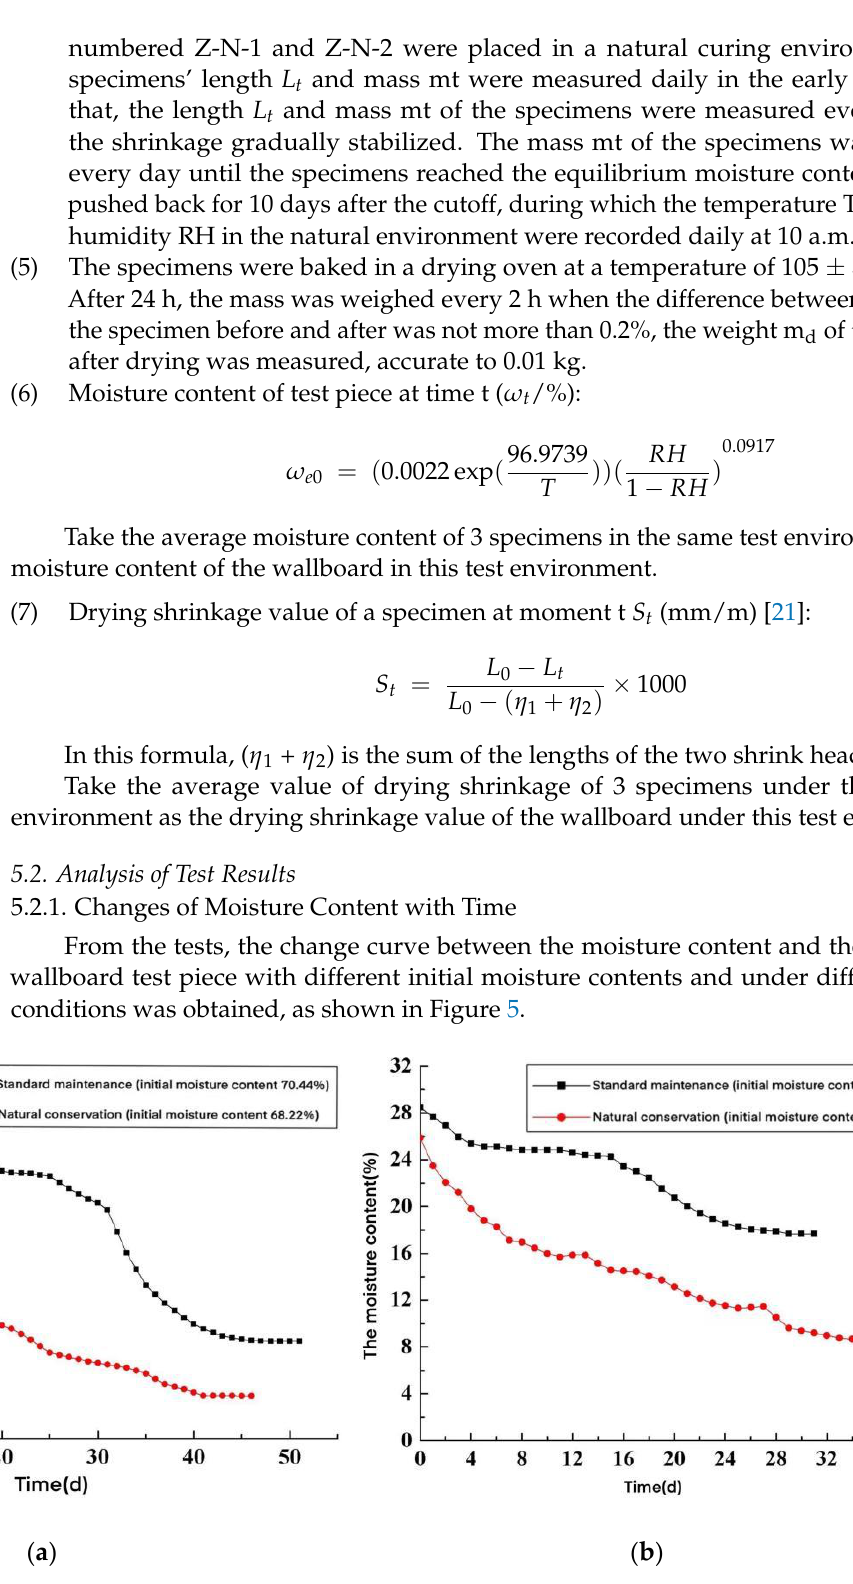
Table 9. Changes of moisture content on different